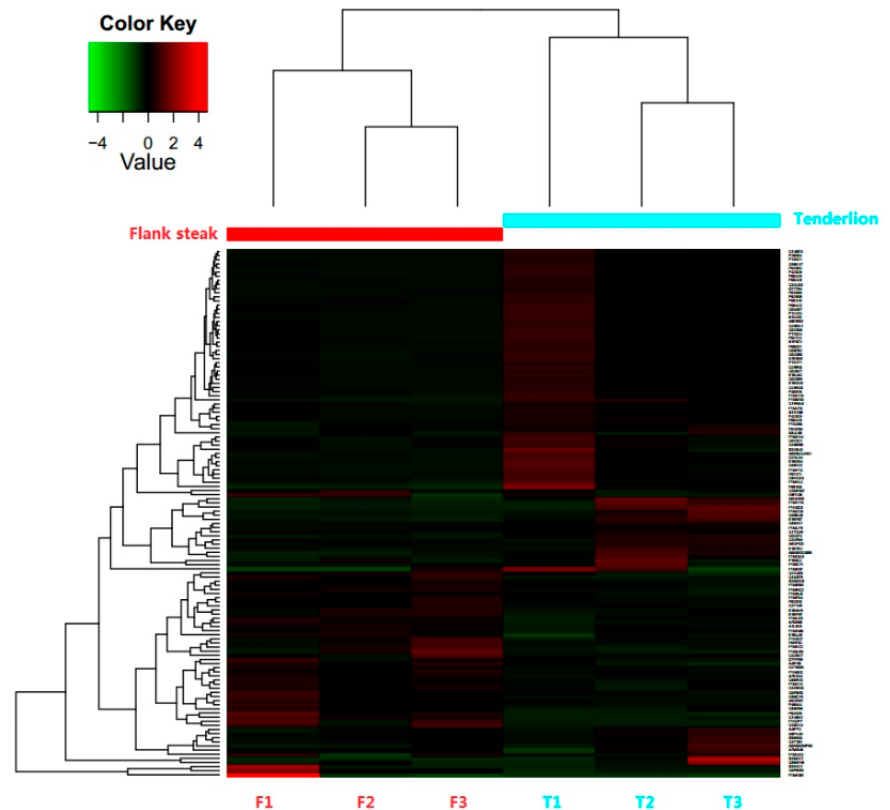
Figure 1. Hierarchical clustering of differentially expressed proteins (DEPs) between tenderloin and flank steaks in beef cattle. Each row represents one protein. Columns F1, F2, and F3 represent samples from three technical replicates for flank steaks, and columns T1, T2, and T3 represent samples from three technical replicates for tenderloin steaks, and flank steaks in beef cattle samples belong to group F, whilst tenderloin steaks in beef cattle samples belong to group T. The expression levels of proteins are shown in red (up-regulated) and green (down-regulated).